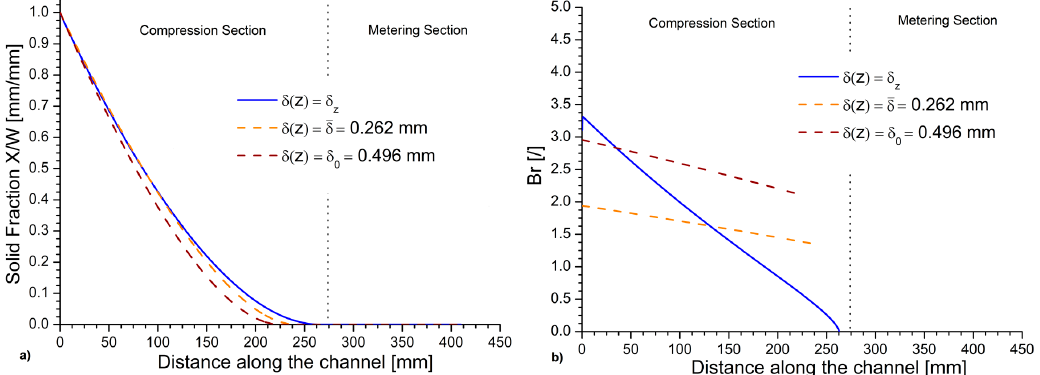
Figure 5. Relevance of model with explicit melt layer thickness variation versus an average one (either evaluation at initial value (orange dashed line) or actual overall average of detailed simulation (brown dashed line)): ( a ) solid bed profile; and ( b ) Brinkman number. The case of micro-extruder in Figures 3 and 4.